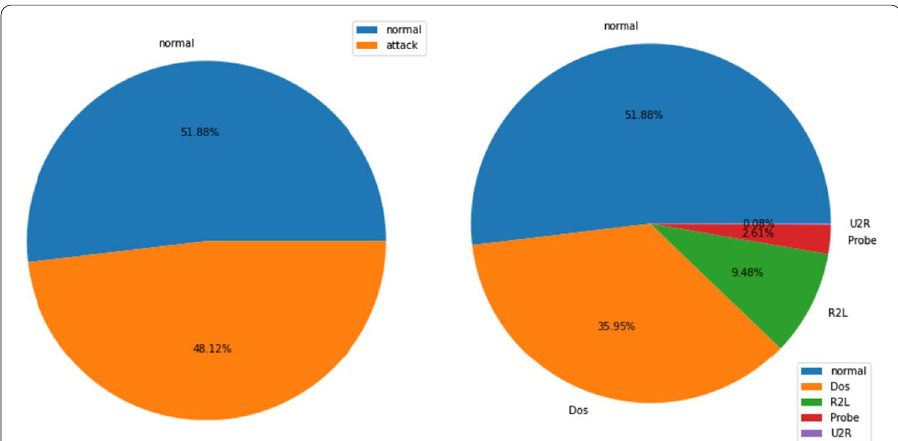
Fig. 6 Distribution of normal and attacks records in “NSL-Binary.csv” and